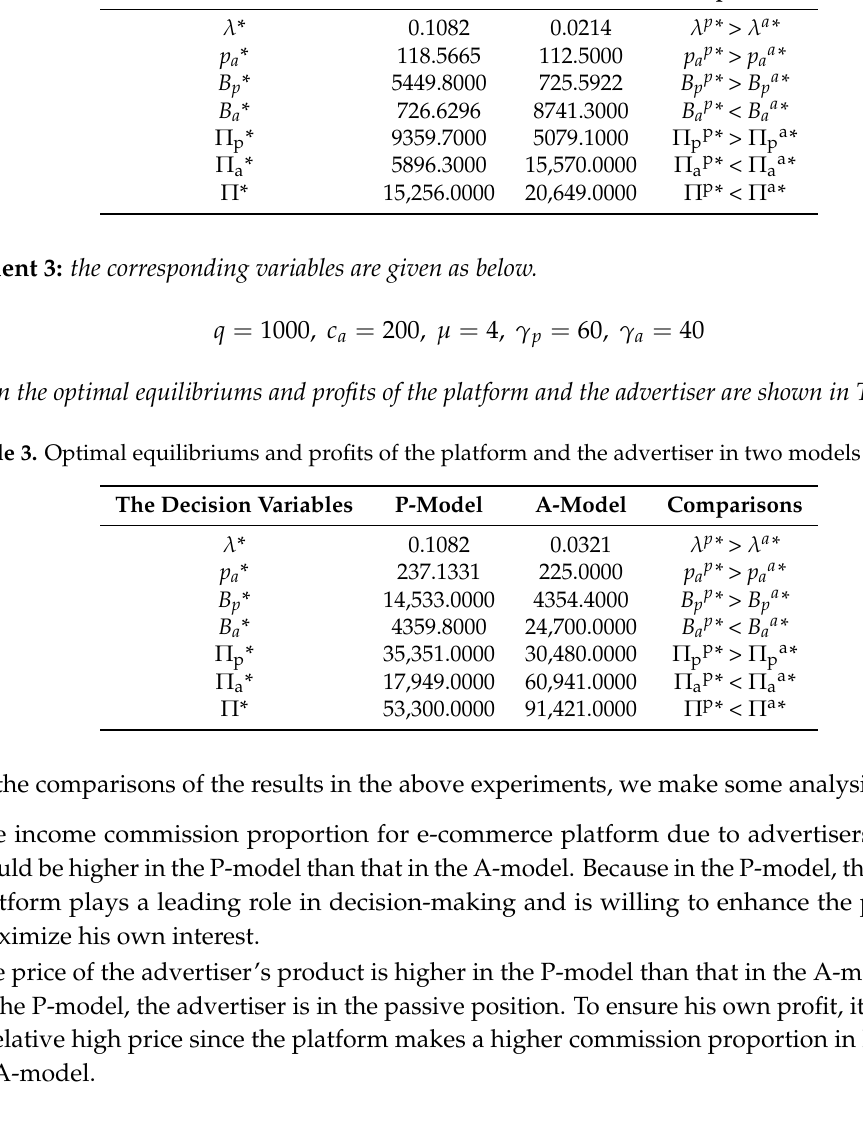
Table 2. Optimal equilibriums and profits of the platform and the advertiser in two models in Exp. 2. The Decision Variables